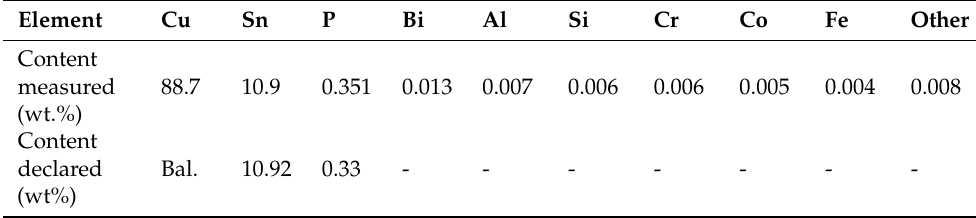
Table 1. Measured and declared chemical compositions of Cu-10Sn